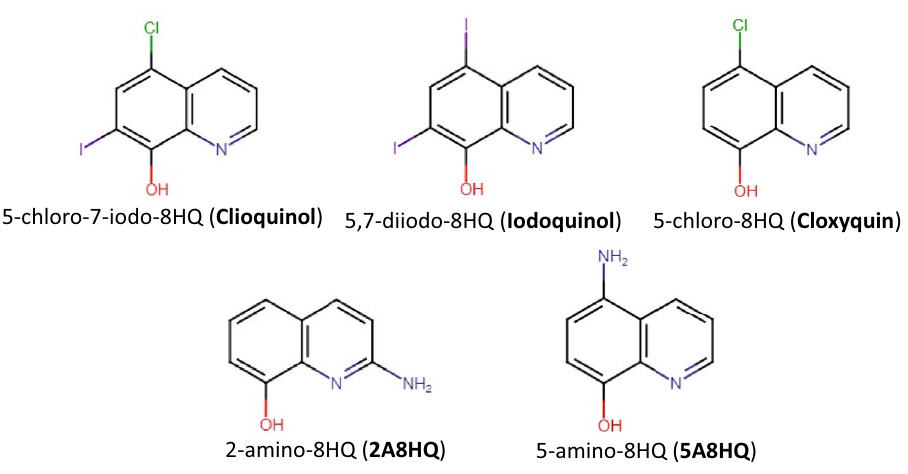
Figure 1. Chemical structures of 8HQ